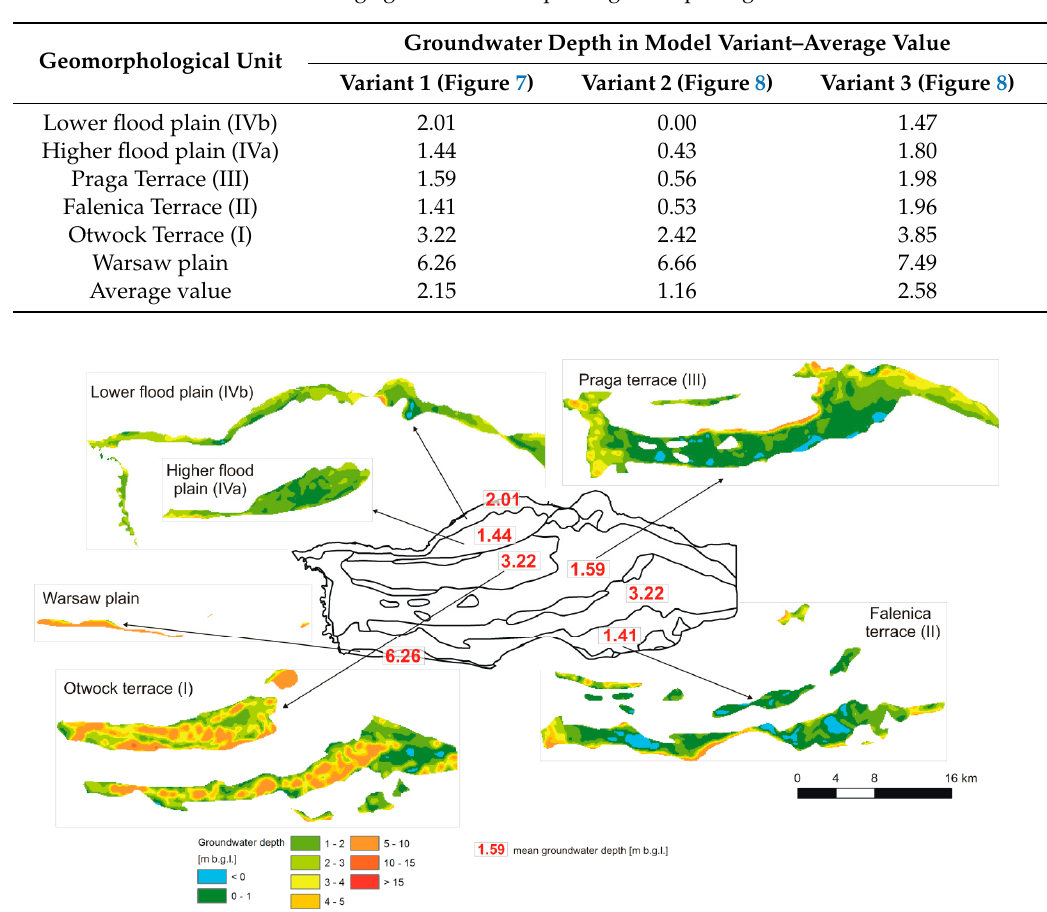
Table 3. Average groundwater depth in geomorphological units.